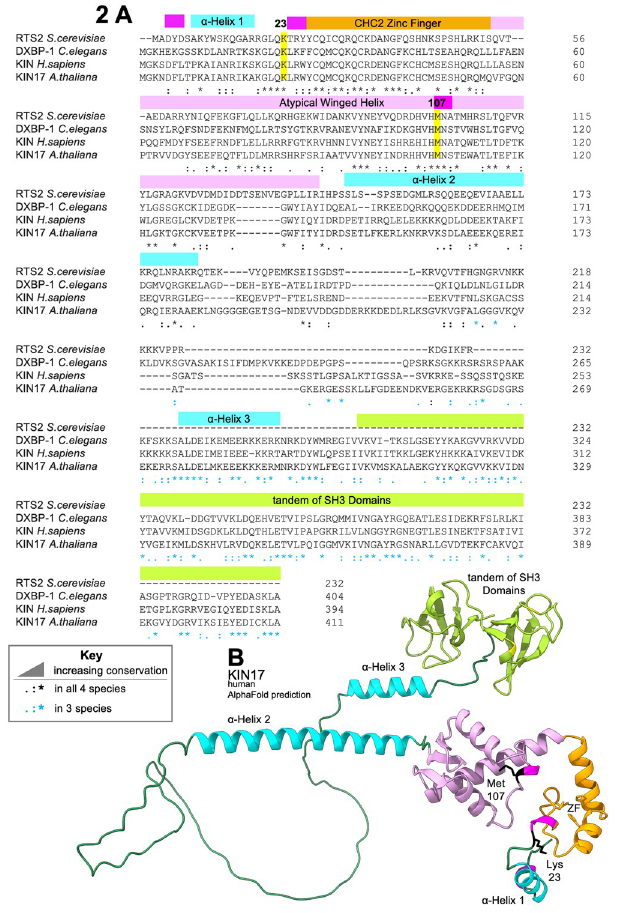
Fig 2. N-terminus of KIN17 is Highly Conserved Between Yeast, Worm, Human and Arabidopsis. A. Multiple sequence alignment of KIN17 and orthologs. 3 10 turns in magenta, numbered α -helixes in cyan, residues K23 and M107 are highlighted in yellow, the zinc finger in orange, the atypical winged helix in orchid pink, and the tandem of SH3 domains in light green. Sequence conservation is annotated as described in the key. Alignment generated in Clustal Omega [25]. B. AlphaFold predicted structure of human KIN protein [24], colored to match the multiple sequence alignment above. Lysine 23 and Methionine 107 in black.